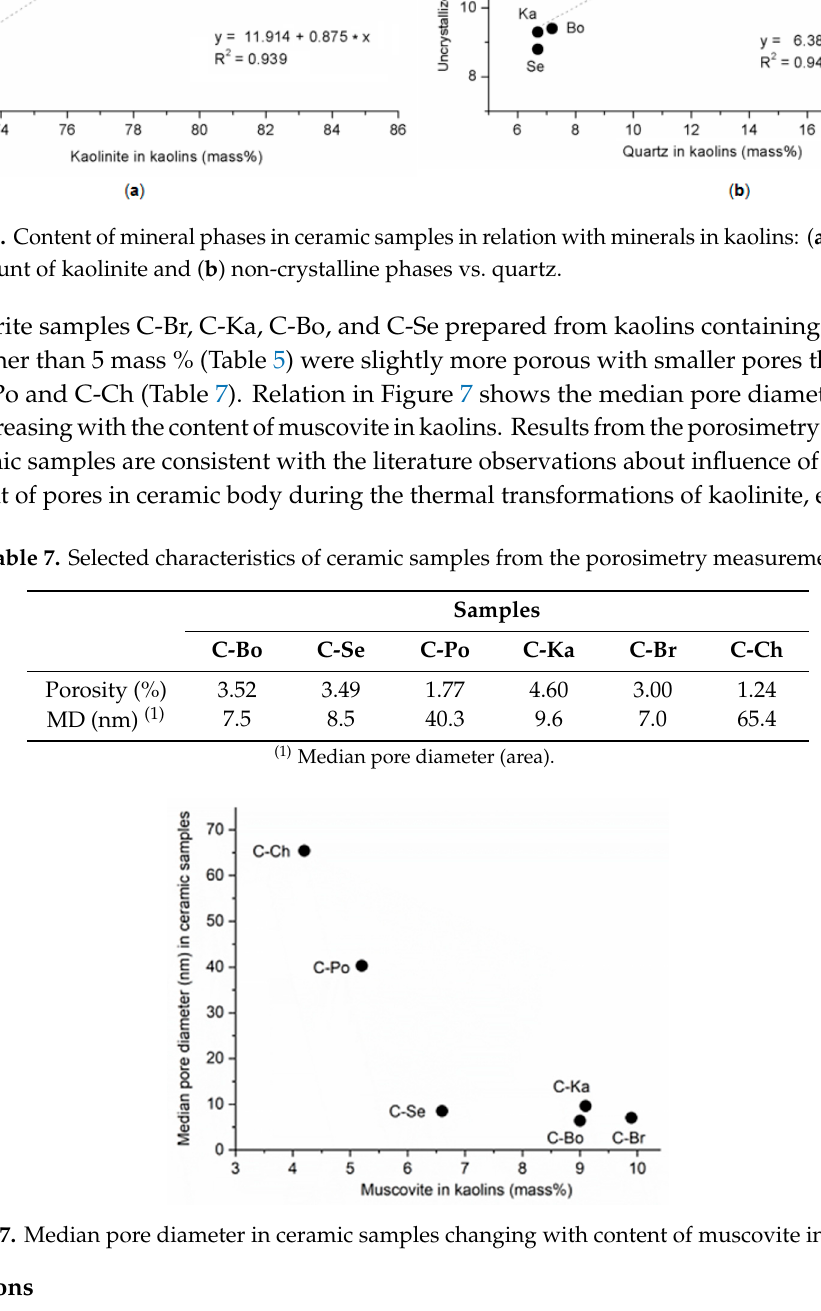
Figure 5. Relationsships between: ( a ) temperature Δ T 5 vs. amount of K 2 O in ceramic samples and ( b ) unit cell parameters c vs. a of indialites. The parameters labeled as: 1: Mg 2.00 Al 4.00 Si 5.00 O 18 [4]; 2: